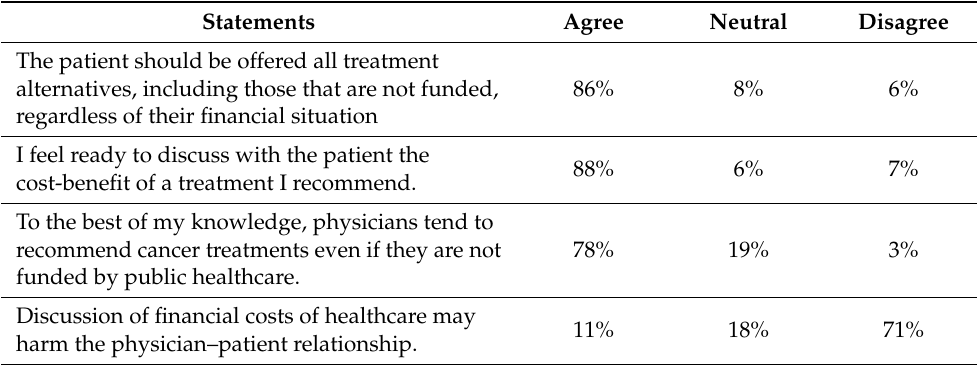
Table 3. Survey response